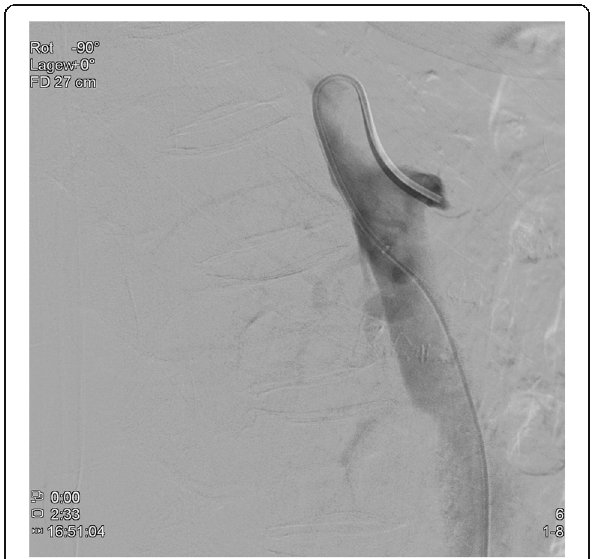
Fig. 1 Abdominal angiography in lateral projection with a Sidewinder 1-catheter in the stump of chronically occluded